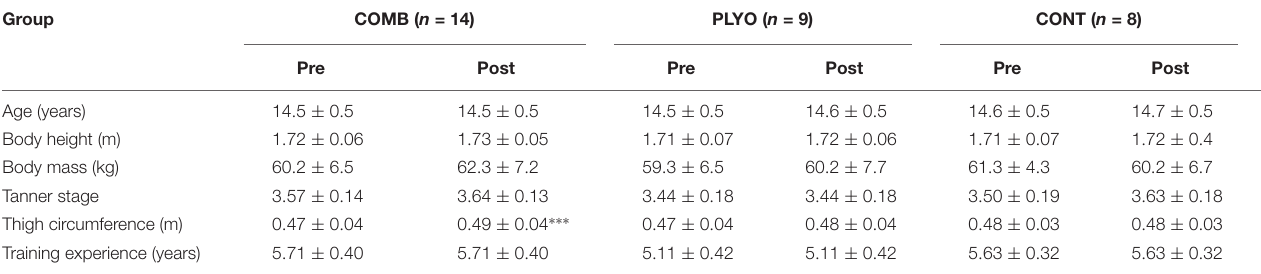
TABLE 1 | Anthropometric characteristics of combined (COMB), plyometric (PLYO), and control (CONT) groups before and after training. Group COMB ( n = 14) PLYO ( n = 9) CONT ( n = 8) Pre Post Pre